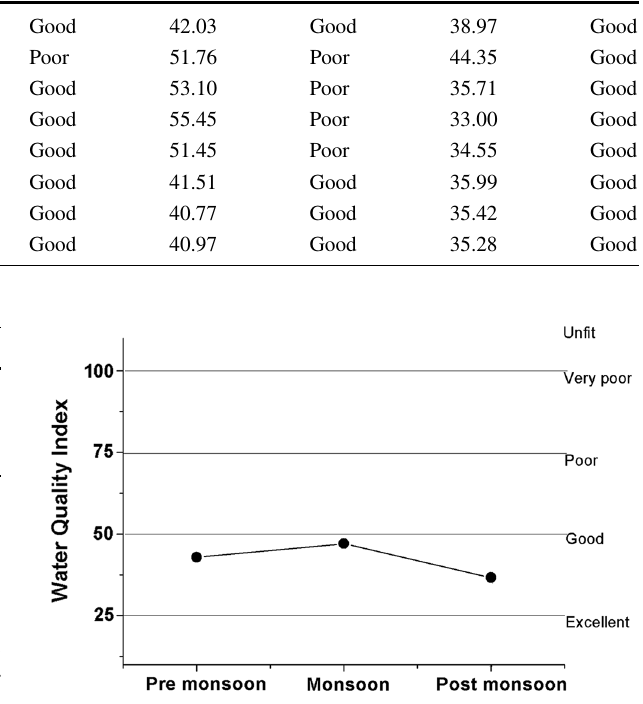
Table 13 Summary of WQI of Doyang River along with its water quality status (WQS)